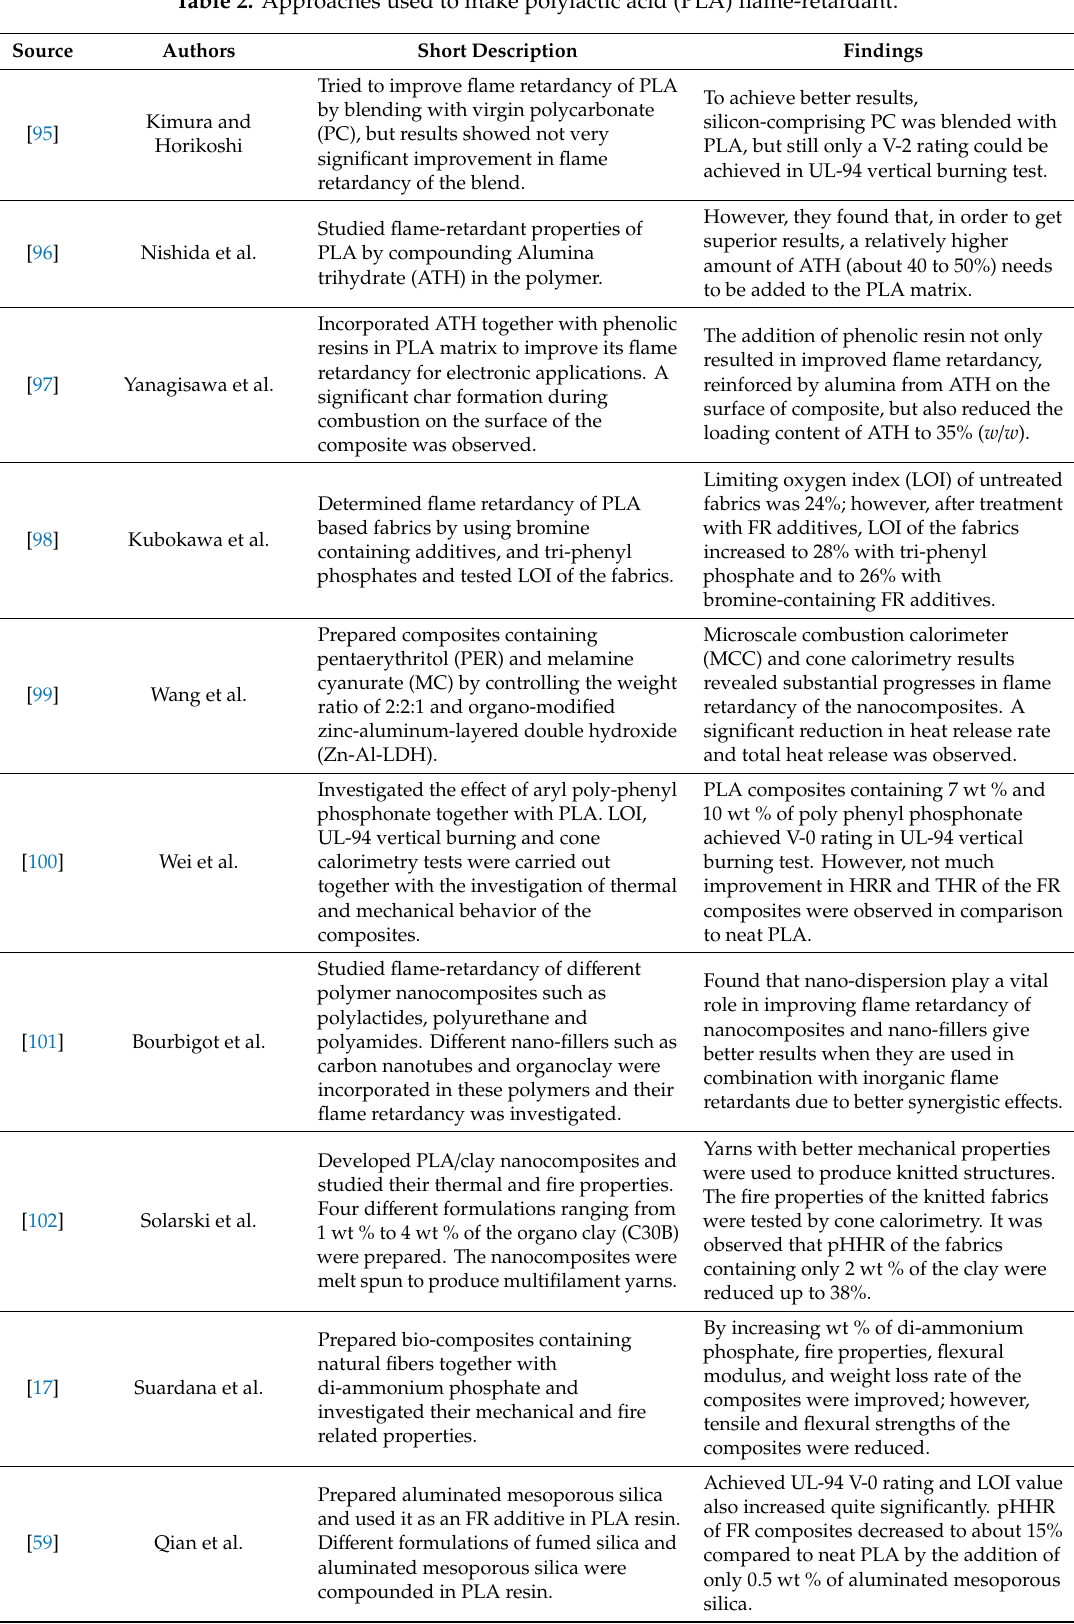
Table 2. Approaches used to make polylactic acid (PLA)